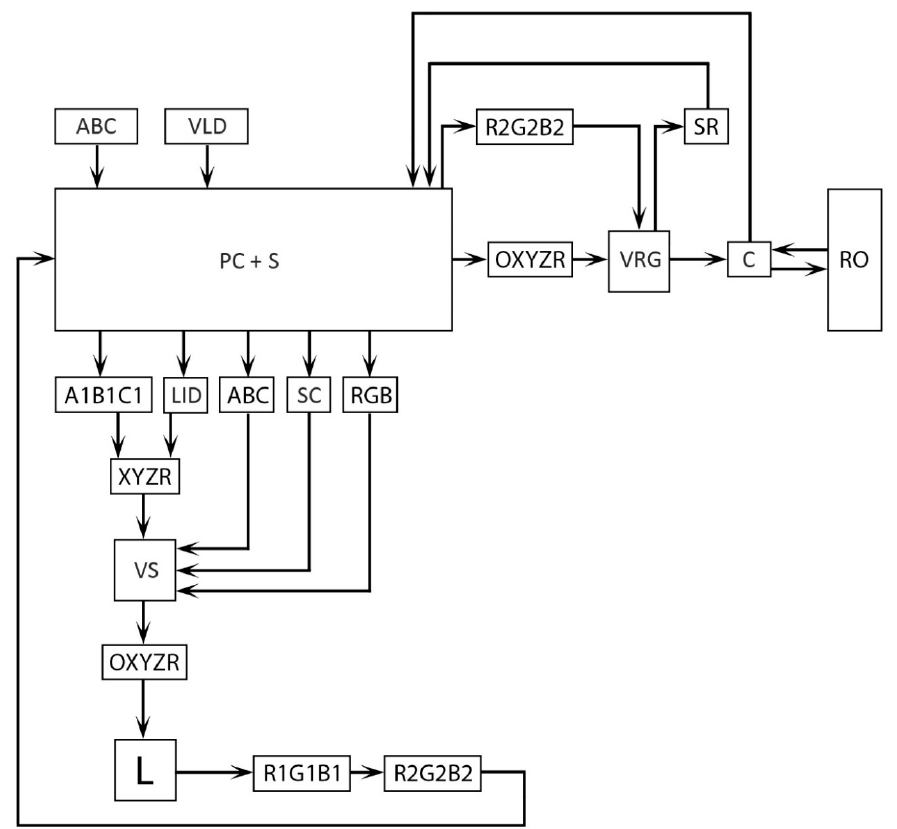
Figure 1. Block circuit of object illumination virtual reality designing system: PC + S—Personal Computer with Software, VRG—Virtual Reality Glasses, SR—Spectroradiometer, C—Camera, RO—Real Object, ABC—Virtual Model of Object, VLD—Virtual Luminaire Data, A1B1C1—Luminaire Dimensions, LID—Luminaire Intensity Distribution, SC—Spectral Composition of Light, RGB—Colour Components of Real Object, XYZR—Position and Orientation of Virtual Luminaire Data (VLD), OXYZR—Observer’s Position and Orientation, L—Luminance Distribution, R1G1B1—Colour Compositions of Light (L), R2G2B2—colour compositions of di ff erential image between RGB and